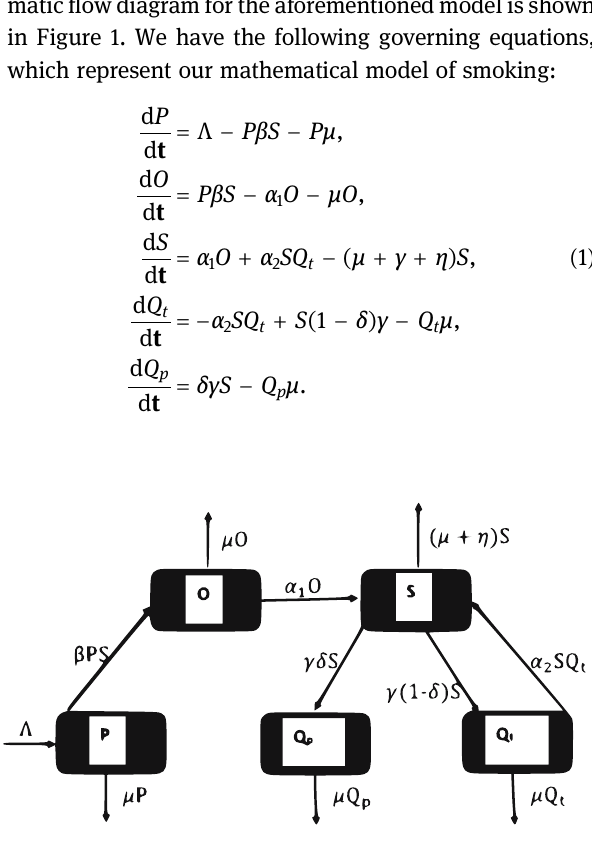
Figure 1: Flow diagram of the model representing the transition of population among di ff erent compartments with various